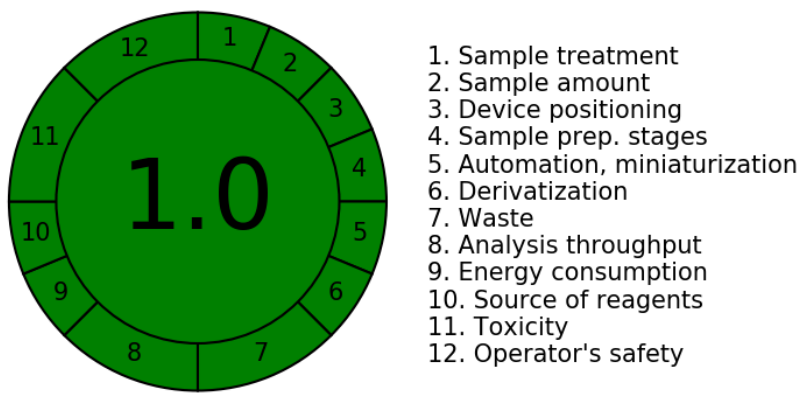
Figure 2. Greenness evaluation criteria as suggested by the AGREE method after readjusting criteria numbers 7, 8, 11 and 12 to have a weight of four.